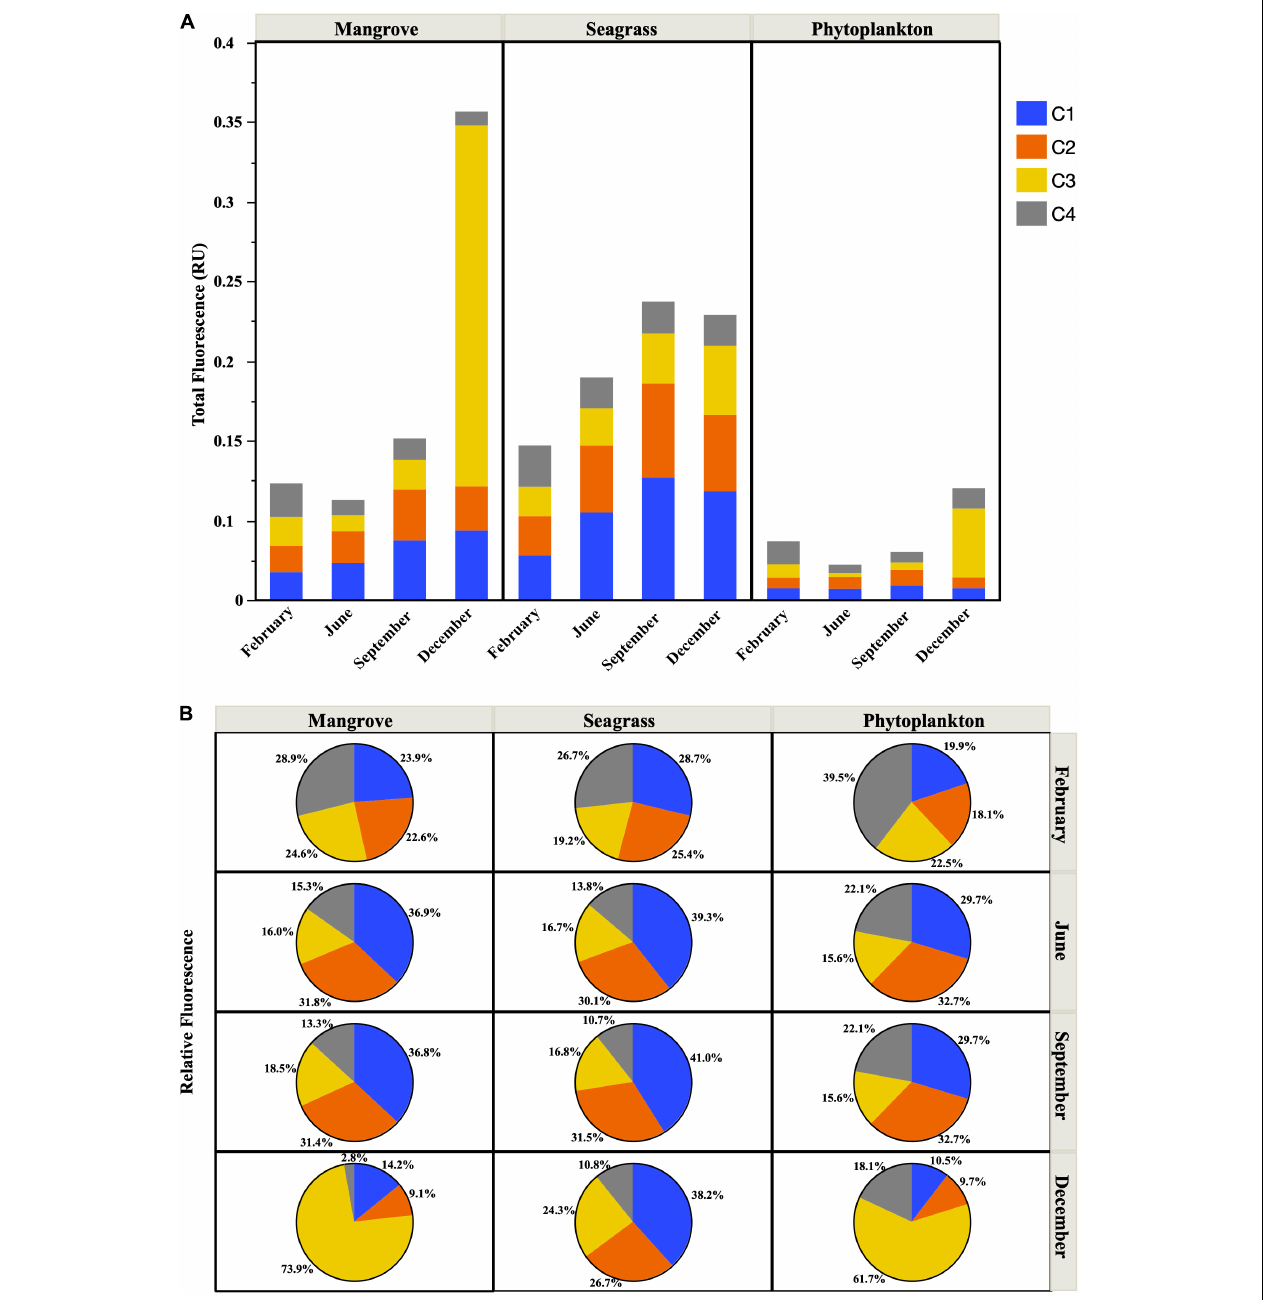
FIGURE 3 | Total fluorescence (Raman Units, RU) (A) and relative abundance of the FDOM components C1, C2, C3, and C4 (B) at the time of sample collection at the three